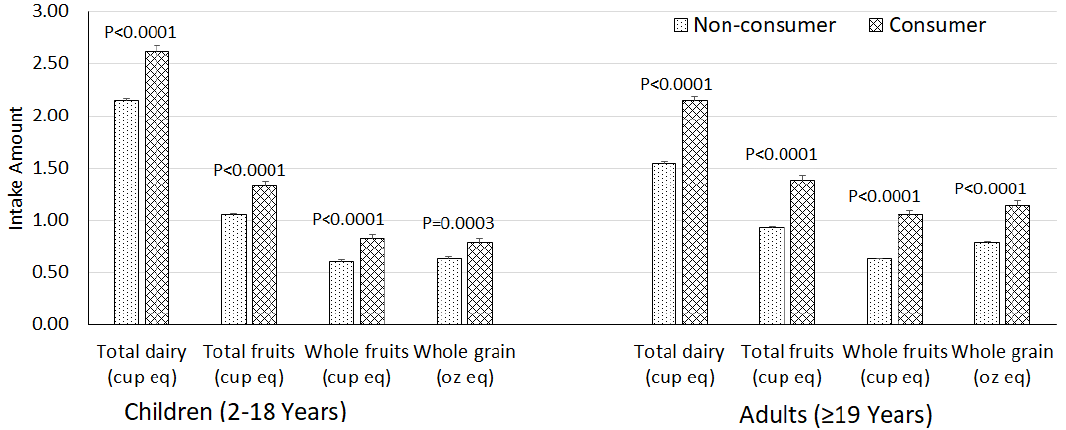
Figure 1. Covariate-adjusted select food groups intakes in children and adult yogurt consumers and non-consumers (NHANES 2001–2016, gender combined data). Values are least square means ± standard error of means, adjusted for age, gender, ethnicity, poverty income ratio, physical activity level, current smoking status, and alcohol (only for ≥19 years), and kcal. p values are for difference between consumers and non-consumers.